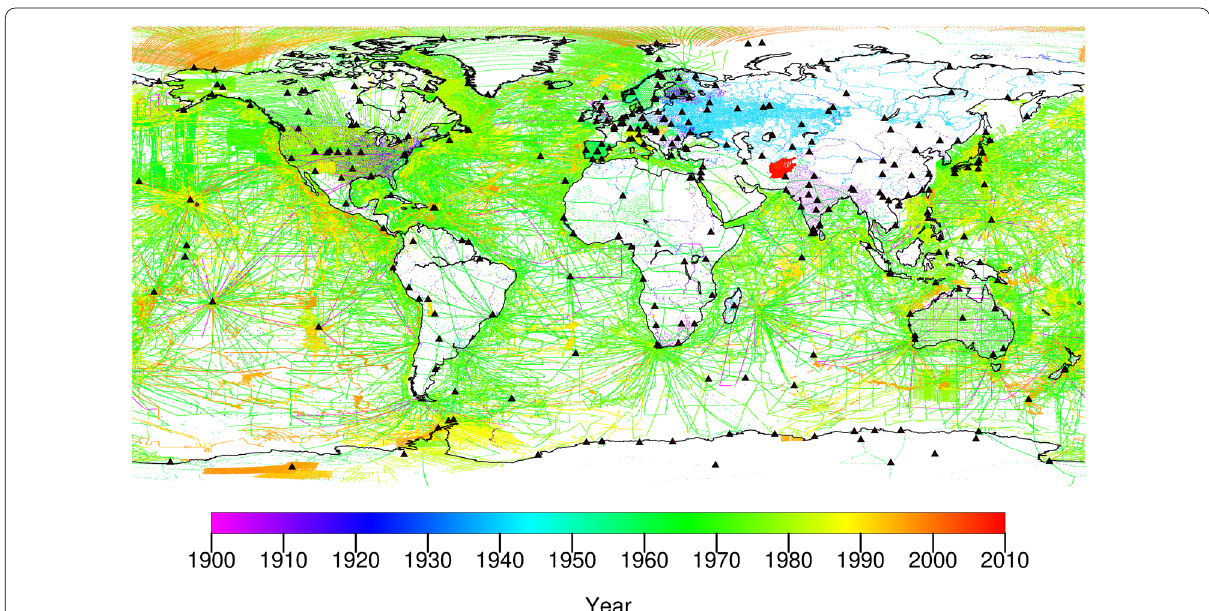
Fig. 1 Locations (dots) and epoch (color) of each land, airborne and marine survey measurement. Black triangles correspond to every ground‑based observatories feeding the model with